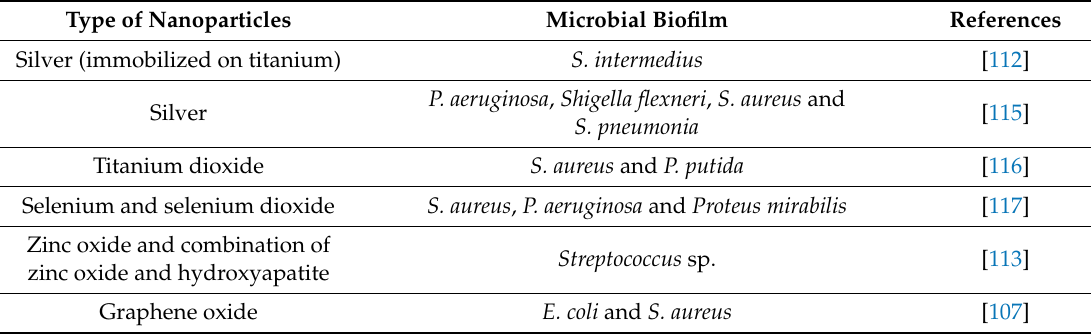
Table 5. Examples of nanoparticles with anti-biofilm activities.